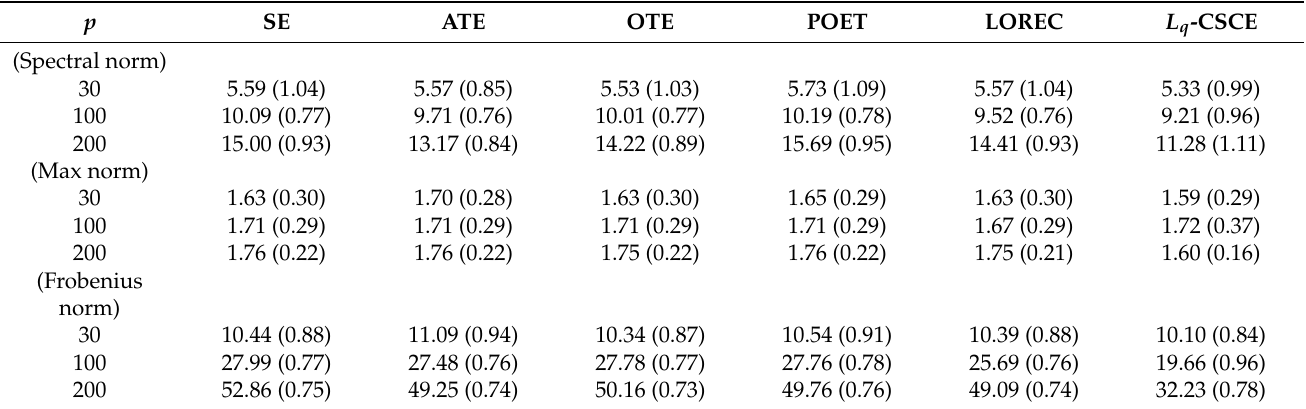
Table 3. Simulation results for Model 3 over 100 replications. The standard errors are given in parentheses.